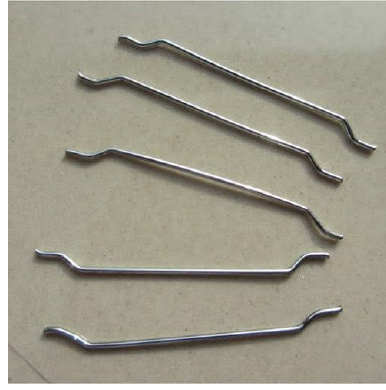
Figure 2. Steel fiber. Table 2. Concrete properties.